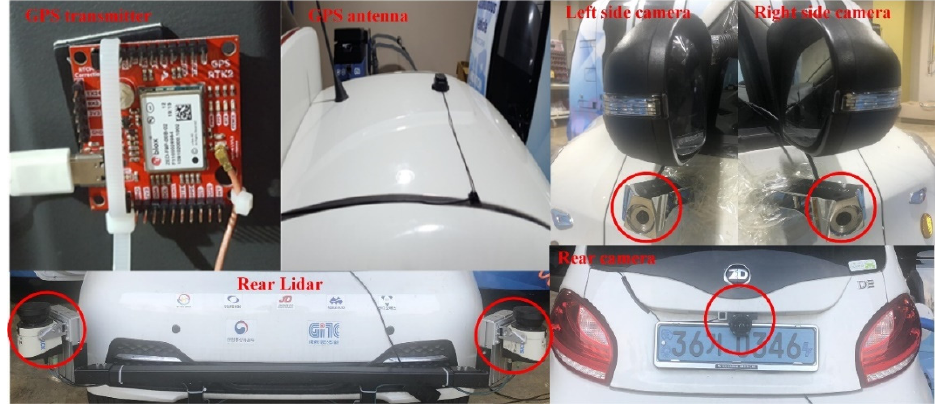
Figure 8. Multiple sensors (GPS, LIDAR, and camera) installed in the micro e-mobility vehicle.